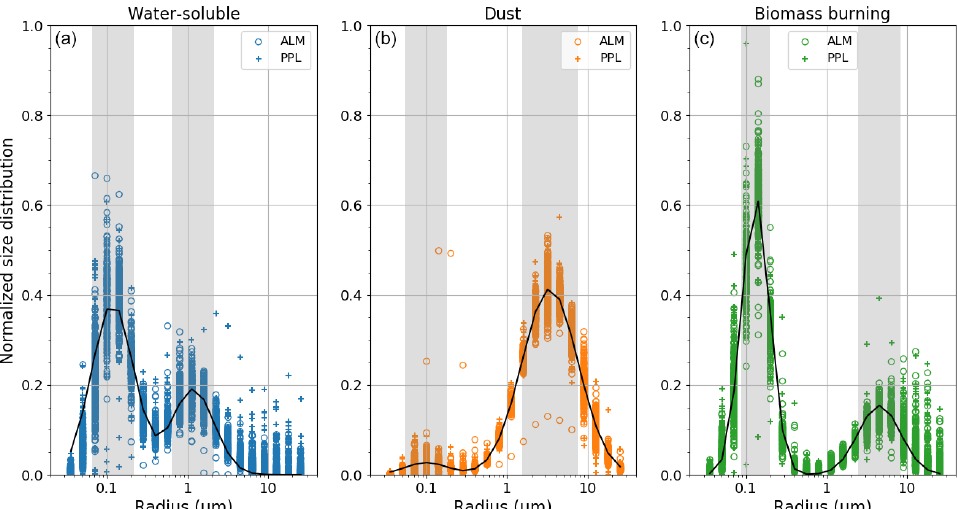
Figure 2. The retrieved (circle and plus) and simulated (solid line) volume size distributions for water-soluble (left, blue), dust (center, orange), and biomass burning (right, green). The size distribution is normalized to the total volume. Circle and plus symbols indicate that the scanning patterns of simulated data are the almucantar (ALM) and principal plane (PPL) geometries, respectively. The shaded area is the range of the radius around the peak of the fine and coarse modes. The range of the radius around the peak is defined as mode radius ± 1 standard deviation (see Table